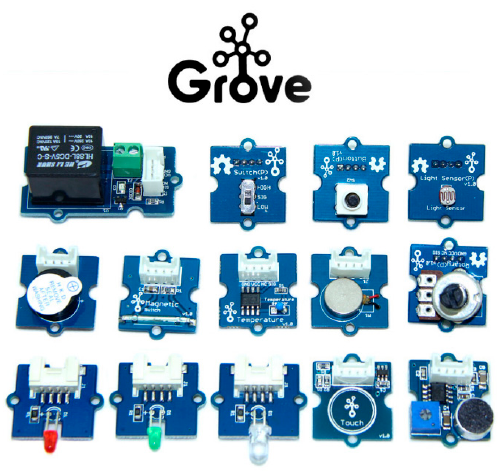
Figure 4. Groove system sensors.